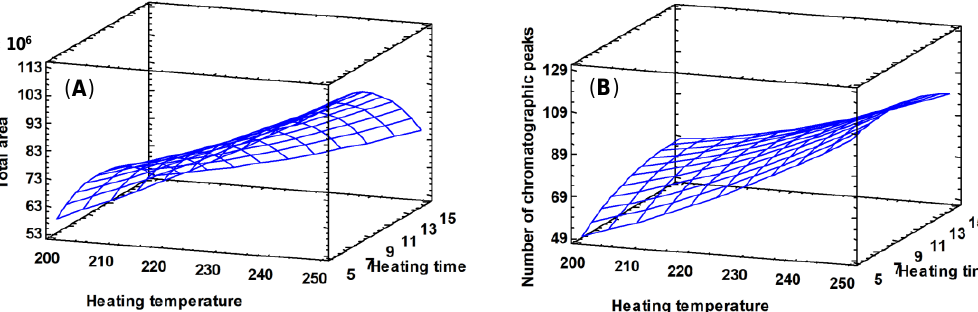
Figure 4. Interaction heating time–heating temperature. Estimated response surface for total chromatographic area ( A ) and for the number of chromatographic peaks ( B ).